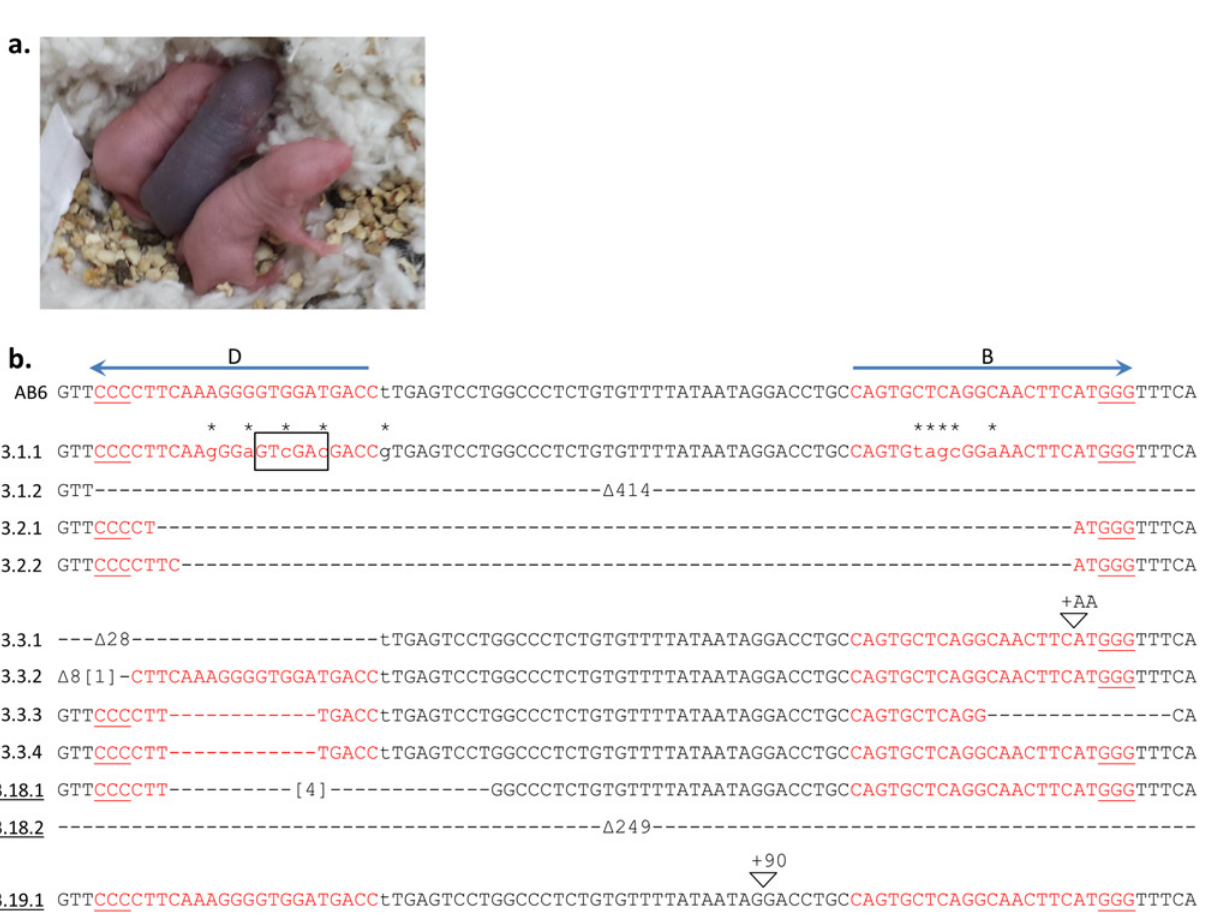
Figure 4. Successful gene repair of point mutation by phenotype and DNA sequencing. (a) Phenotypic results of guide B and D editing of AB6xAB6 fertilized eggs (Experiment 3) resulted in a gain of black coat color in one of three pups photographed on day 5 after birth. Mice 3.1 (black pup), 3.2, and 3.3 are shown. (b) The results of combined guide B and D editing in AB6 mice with a donor template are depicted. When a modified donor was used, the mutations are indicated by ( * ) above the lowercase base substitutions. Mice are numbered as in Fig. 2b. The AB6 allele is indicated with the positions of guides B and D as in Fig. 1. Sequencing results from the unaltered Tyr allele 3.19.2 is not shown. Mouse 3.3 is a genetic but not phenotypic mosaic. Underlined alleles were from a D10A Cas9 injection. Deleted nt (-). Inserted nt in brackets. The introduction of a novel Sal I restriction enzyme site is identified by a box for allele 3.1.1.